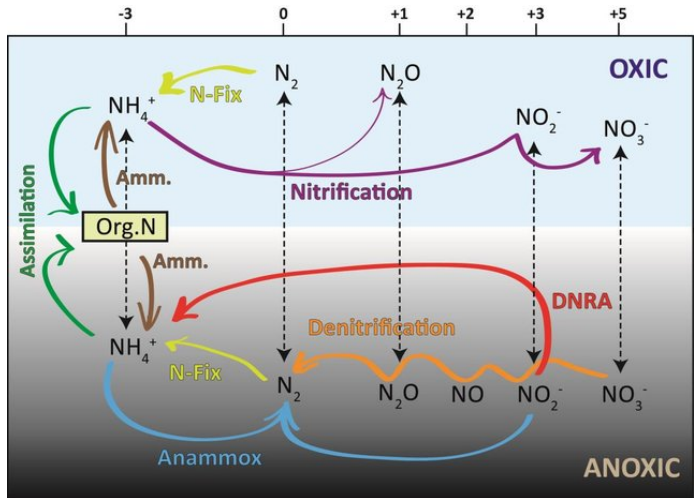
Figure 1. The N cycle showing all oxidizing and reducing transformation pathways occurring in oxic and anoxic habits, particularly in waterlogged saline soils. Ammonification (brown arrows) is the microbial breakdown of organic N to ammonium; the reverse process is assimilation/immobilization (green arrows). Nitrification (purple arrow) is the biological oxidation of ammonium to nitrite followed by oxidation to nitrate. Microbial denitrification (orange arrows) transforms from nitrate along a series of steps to eventual release of N 2 gas. Anaerobic ammonium oxidation (anammox in blue arrows) processes ammonium and/or nitrite to N 2 . Nitrogen fixation (yellow arrows) is the process in which atmospheric N 2 is transformed by specific microbial groups to ammonium and further incorporated into organic N. Table 1. Rates of N transformation processes (mg N m − 2 d − 1 ) in mangrove soils, including N 2 -fixation in soils and on various tree and forest components. All rates are to soil depths of 5–20 cm. Abbreviations: DNRA = dissimilatory nitrate reduction to ammonium; anammox anaerobic